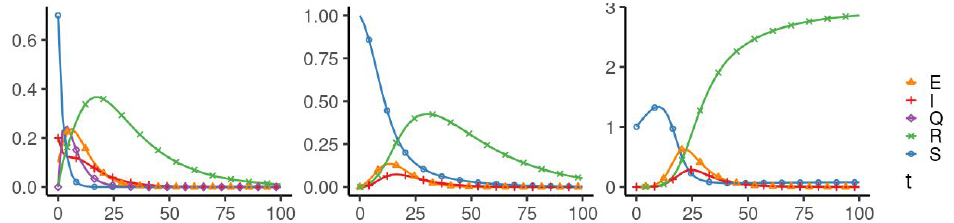
Figure 22. Experiment 4. Spread of the virus in the controlled case (irresponsible residents). ( Left ): 1 level, ( middle ): 2 level, ( right ): 3 level.